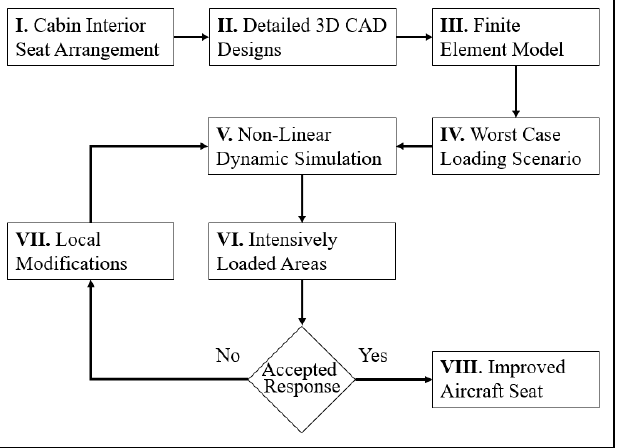
Figure 2. Methodology flow chart for the improvement of the aircraft seat concept.